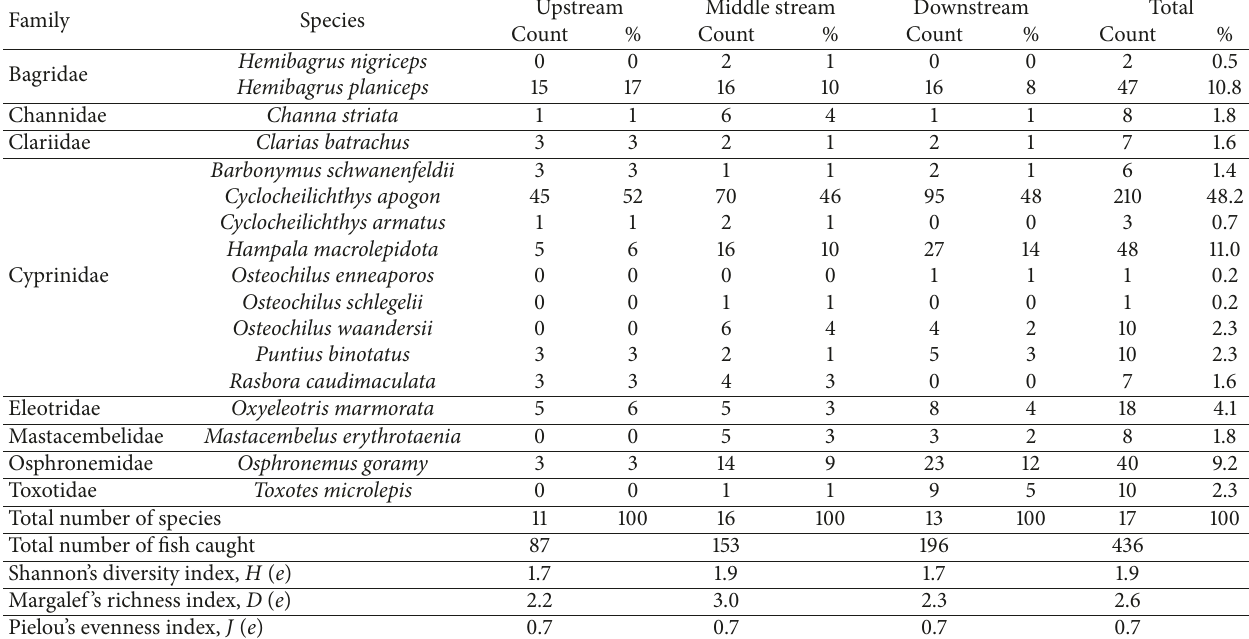
Table 4: Summary of the fish assemblages at the downstream river of Batang